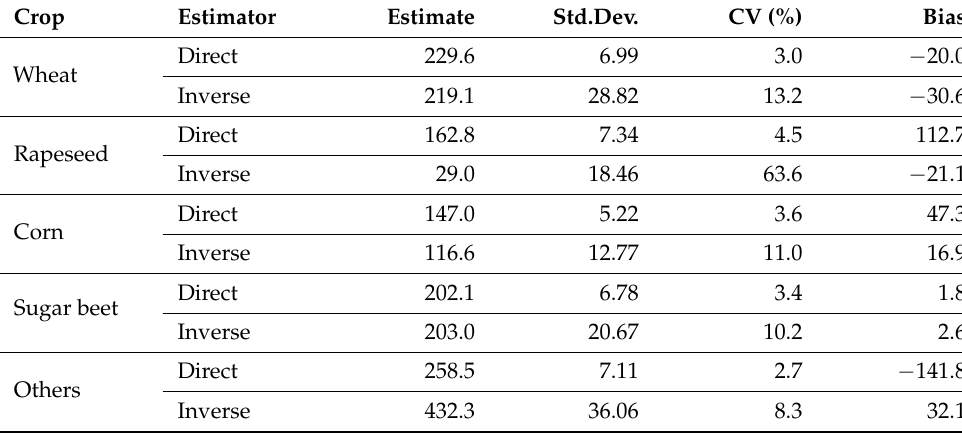
Table A3. Statistical performances per crop for the G strategy.